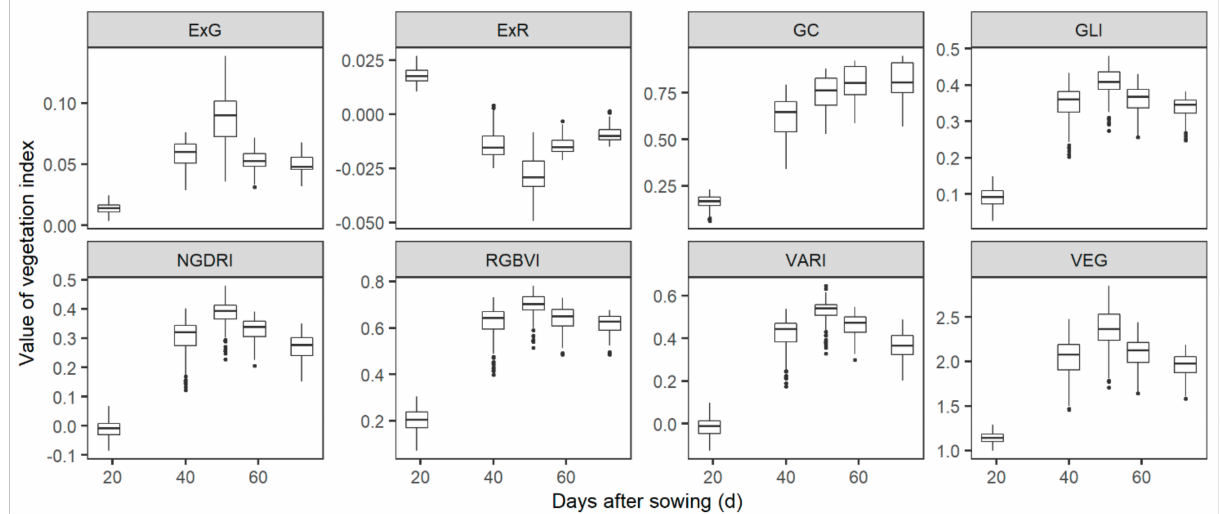
Figure 3. Dynamic changes of the visible indexes before wheat flowering. Visible indexes were calculated from ortho- mosaics that were generated from UAV-sensed RGB images. Detailed information of indexes is listed in Table